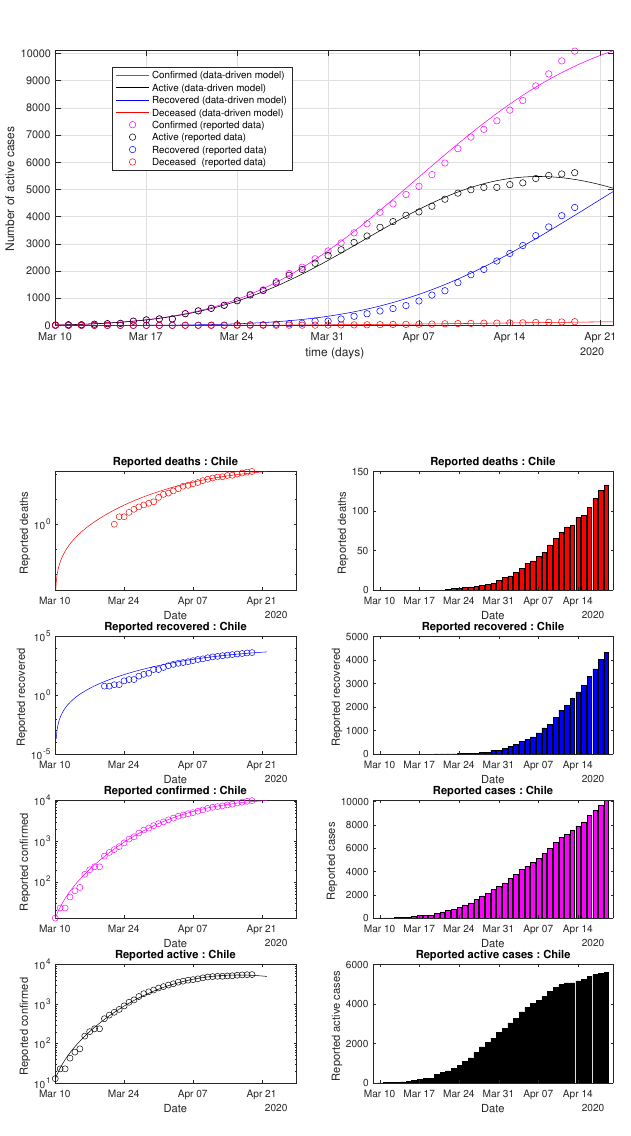
Figure 23. Chile: data of active, recovered, deceased (in circle or bar) vs. model of active, recovered, deceased over time. Tracking the number of active cases. Predictive analytics for the next couple